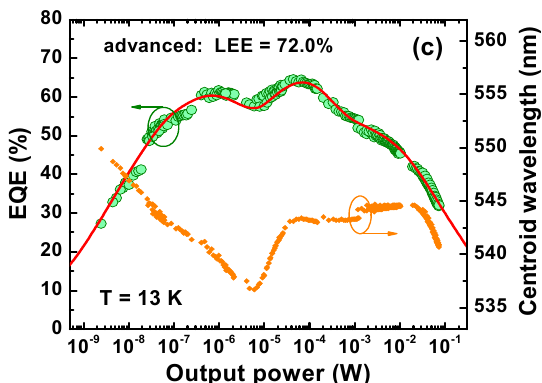
Figure 4. Simple and advanced transition functions used in the simulations ( a ), EQE of the green LED at T = 13 K predicted by modified ABC-model (solid lines) obtained with simple ( b ) and advanced ( c ) transition functions, and emission wavelength as a function of output optical power. Symbols are experimental data points.